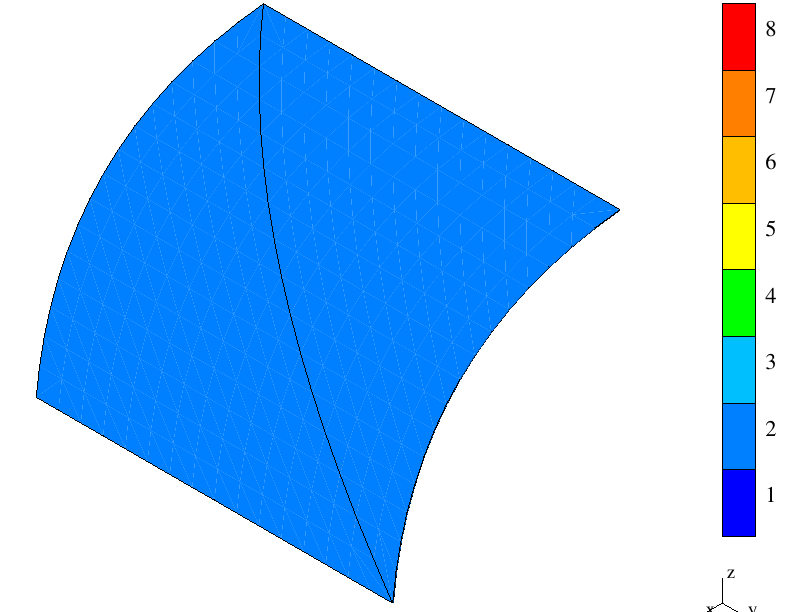
Figure 21. A quarter of a bending-dominated shell—initial